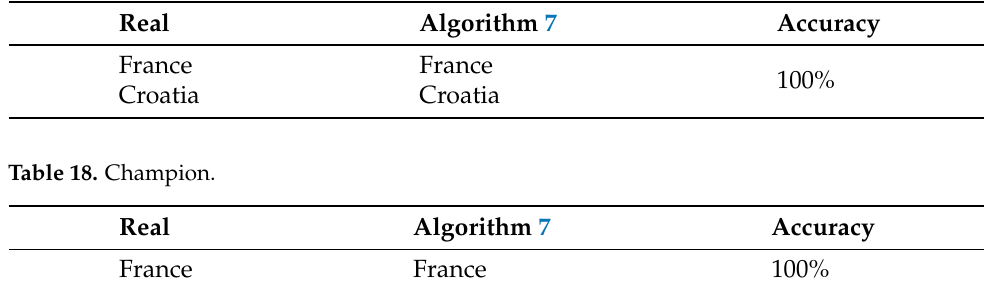
Table 17. Finalists.